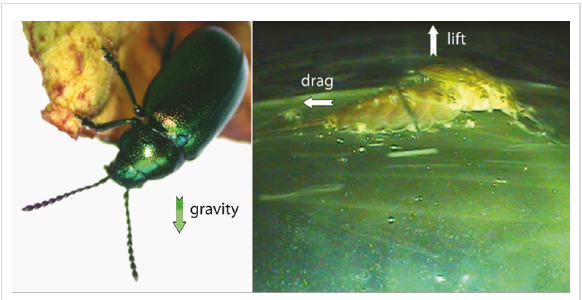
Figure 1: A) Green dock beetle Gastrophysa viridula as an example for terrestrial attachment (image: Stanislav Gorb, reproduced with permission by the author), B) Mayfly larvae Epeorus attaching to a substrate in running water (image: Petra Ditsche). Arrows show the direction of the most important forces acting on the